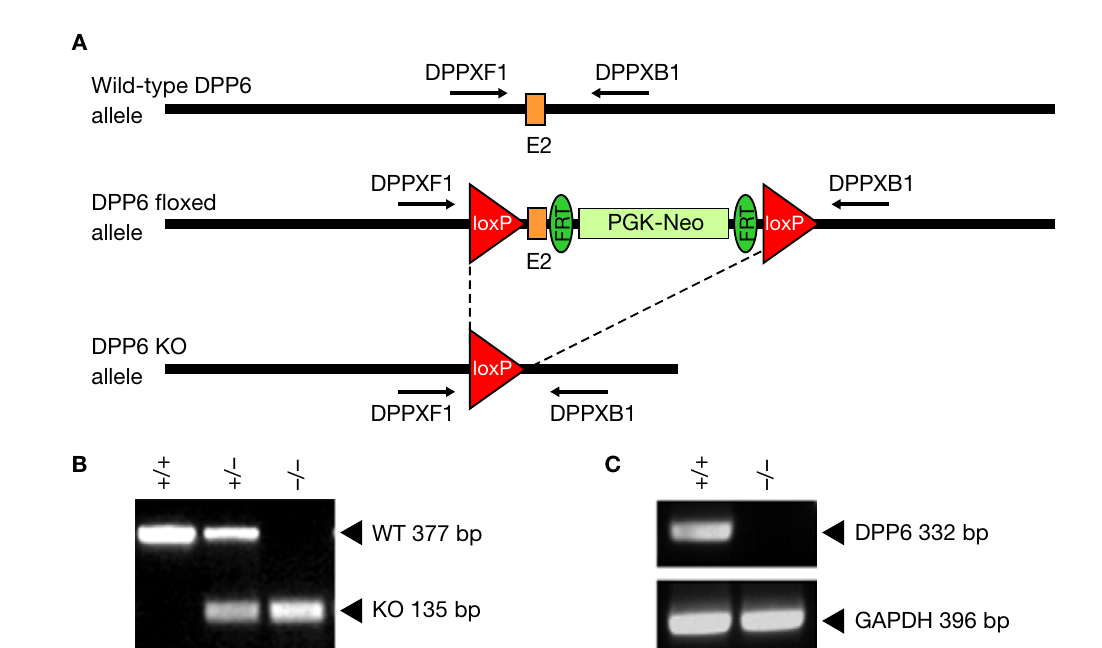
Figure 1 | Strategy for the generation of conditional DPP6 knockout mice. (A) LoxP sites were introduced fl anking exon 2 of the DPP6 gene. Floxed mice were bred to a Cre deleter strain expressing Cre recombinase in the germline to generate null alleles. (B) Genotyping for DPP6 alleles. Amplifi cation products of wildtype, heterozygote and homozygote nulls following PCR with primers DPPXF1 and DPPXB1. (C) RT-PCR of rat brain mRNA demonstrates lack of DPP6 transcripts in DPP6 − / − mice. PCR of GAPDH mRNA was used as